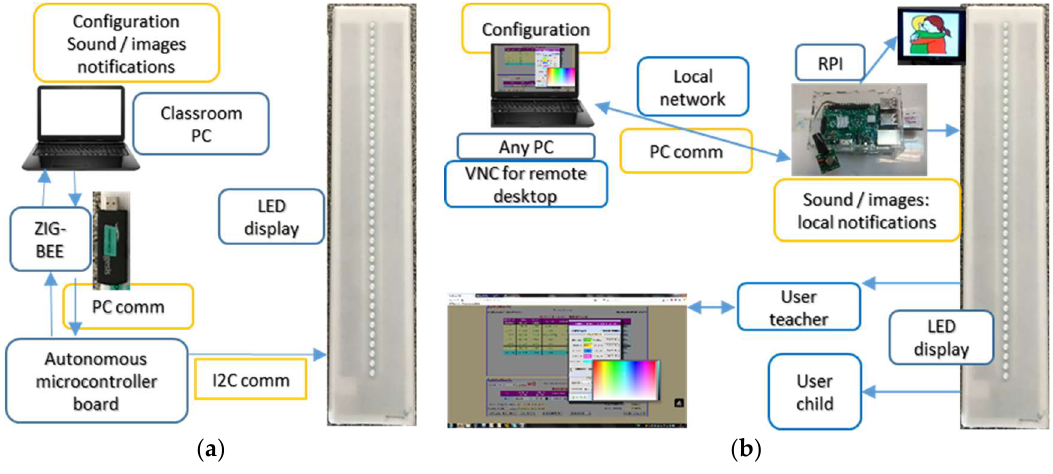
Figure 4. ( a ) TOD version 2; ( b ) TOD version 3.